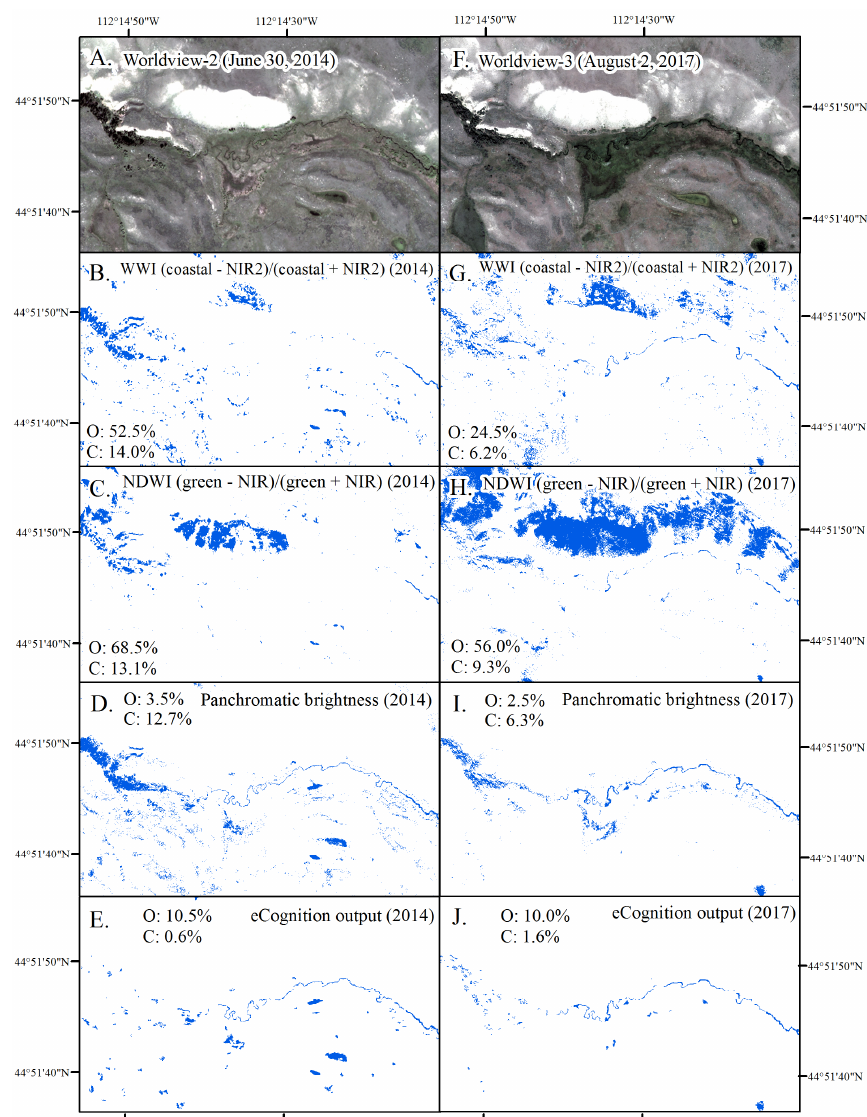
Figure 6. A comparison of mapped surface water extent for a reach of Alkali Creek in which challenges included shaded riparian vegetation (left) and narrow stretches of stream (center). Comparisons include, natural color images ( A , F ); the Worldview Water Index (WWI, B , G ); the Normalized Difference Wetness Index (NDWI, C , H ); the panchromatic brightness ( D , I ); and the eCognition output ( E , J ). O: omission error; C: commission error Copyright DigitalGlobe, 2014, 2017.